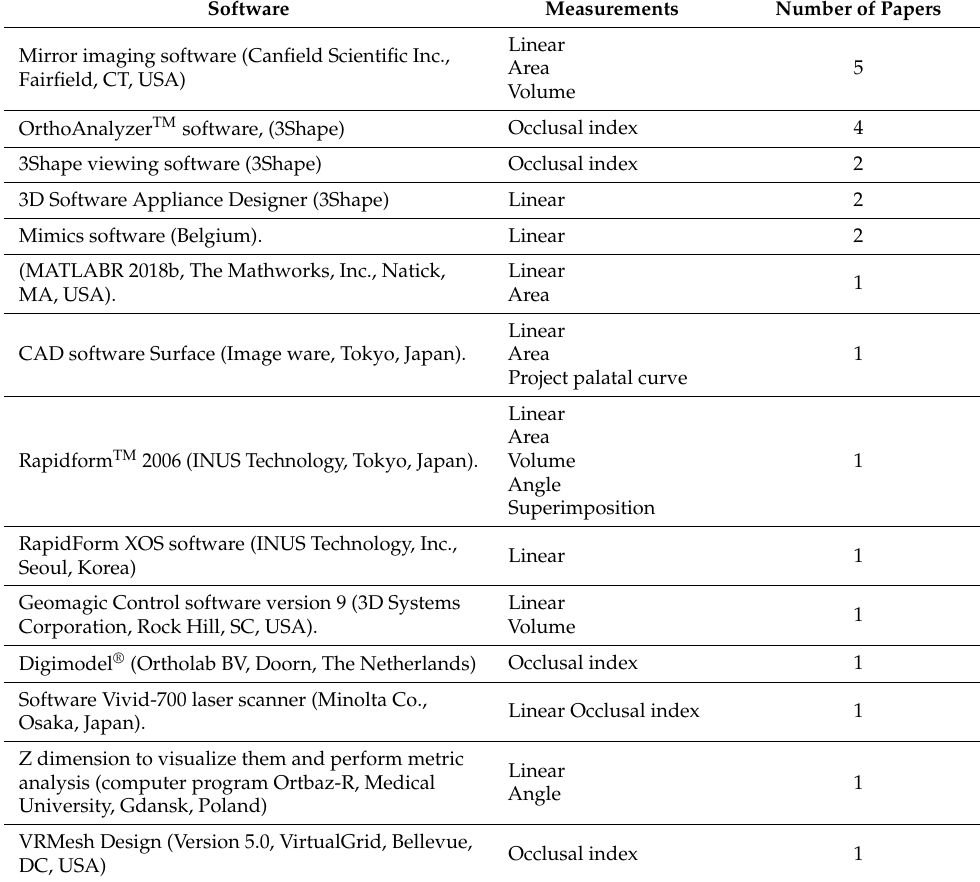
Table 3. Software and measures used in the selected